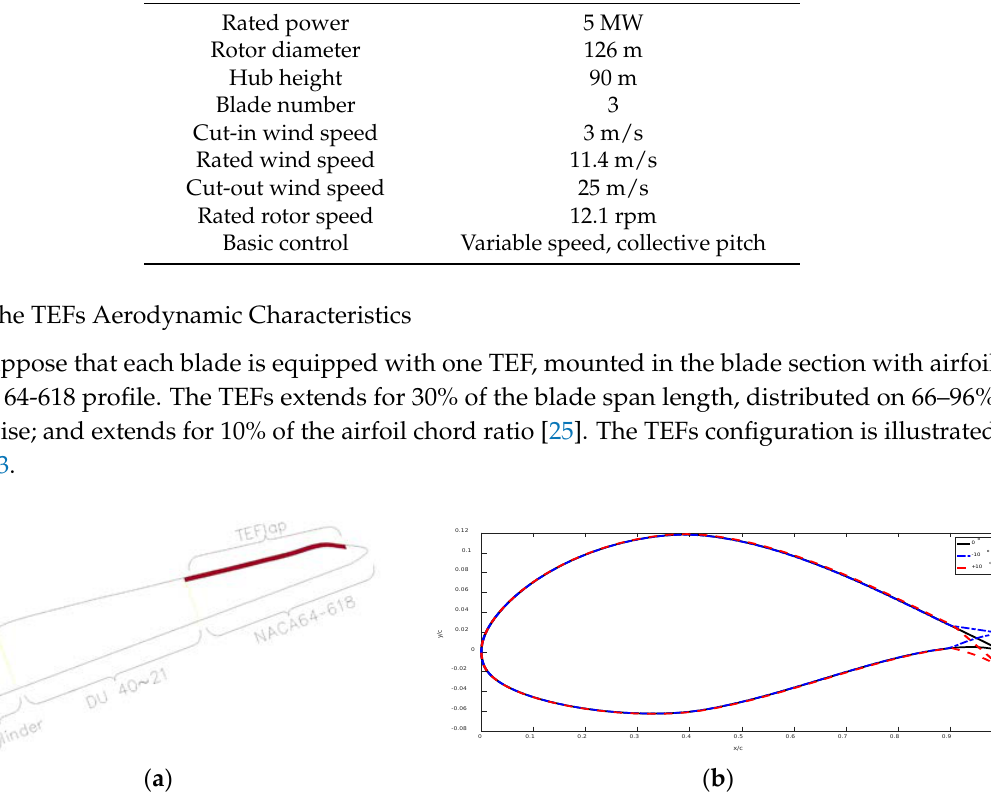
Table 1. The 5 MW reference wind turbine specifications.